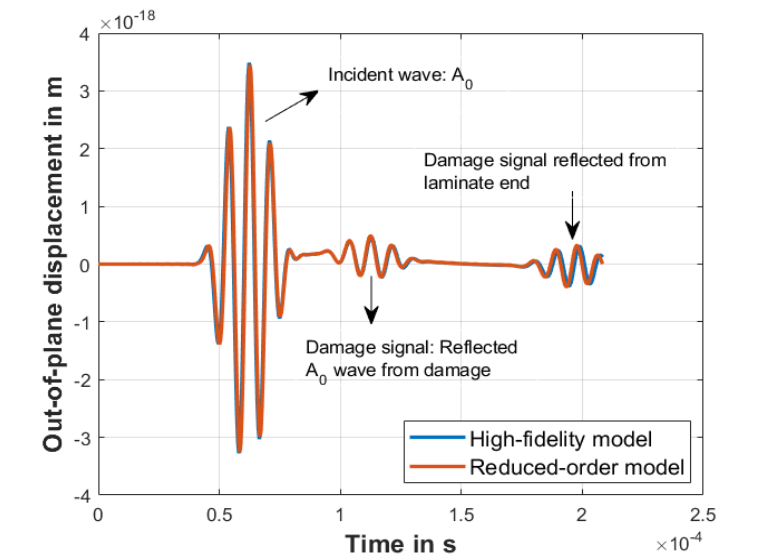
Figure 4. Reduced-order solution produced by the adaptive POD-greedy approach for parameter θ = ( 4.05 GPa,90 mm,4 mm ) considered in Section